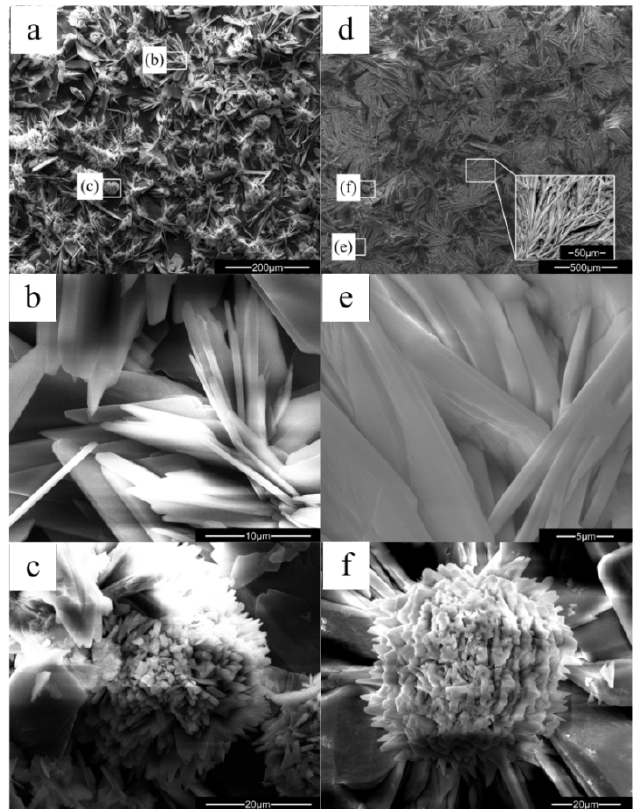
Figure 2. SEM morphologies of the dicalcium phosphate dehydrate (DCPD) coating ( a – c ) and the hydroxyapatite (HA) coating ( d – f